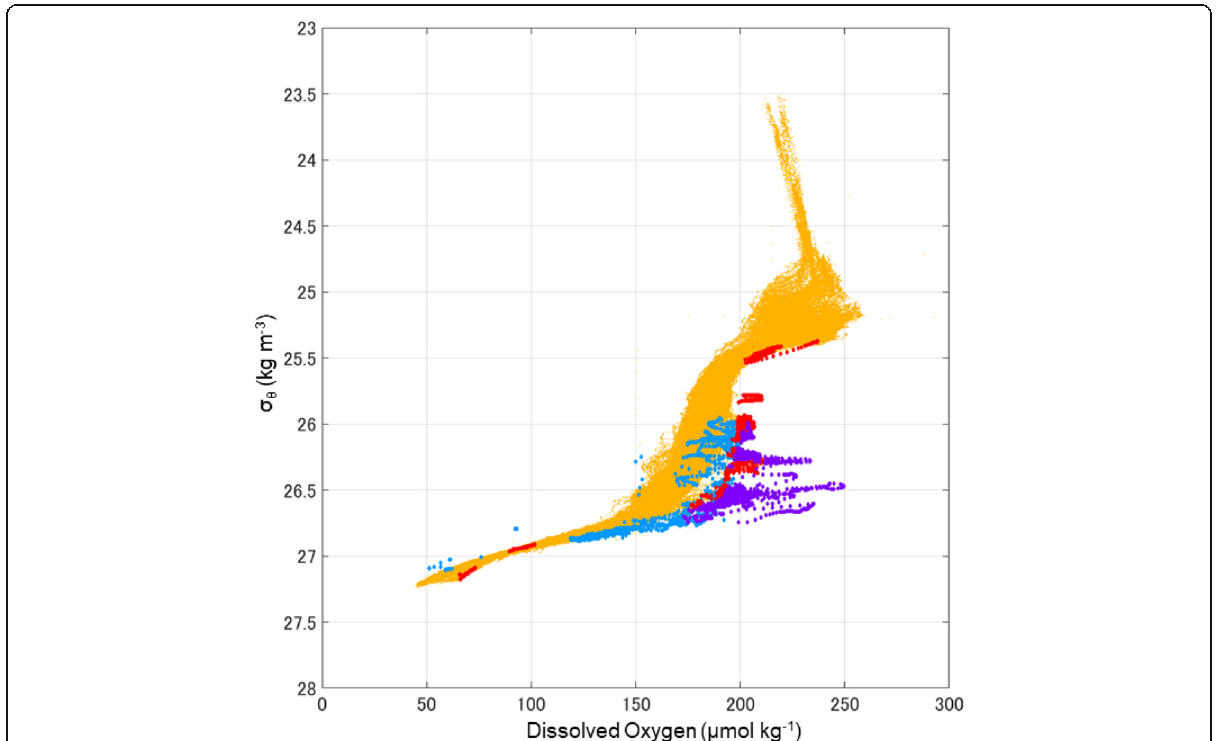
Fig. 10 Same as Fig. 8 except for the σ θ -DO diagram of the Seaglider data, which is colored with over 3 σ of negative salinity anomaly (blue circles), positive DO anomaly (red circles), and both (purple